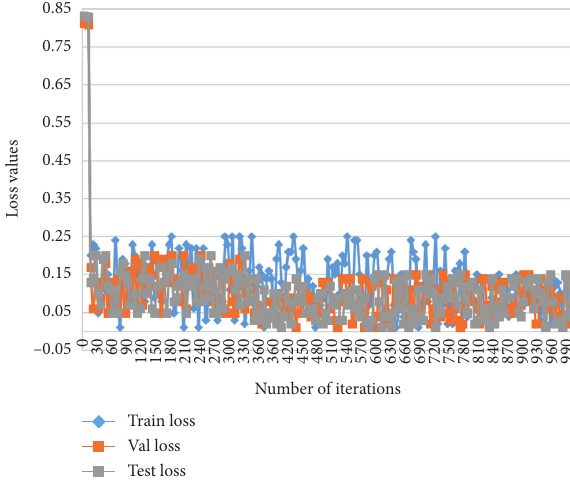
Figure 6: Error curves of the training set, validation set, and test set of the DFCN